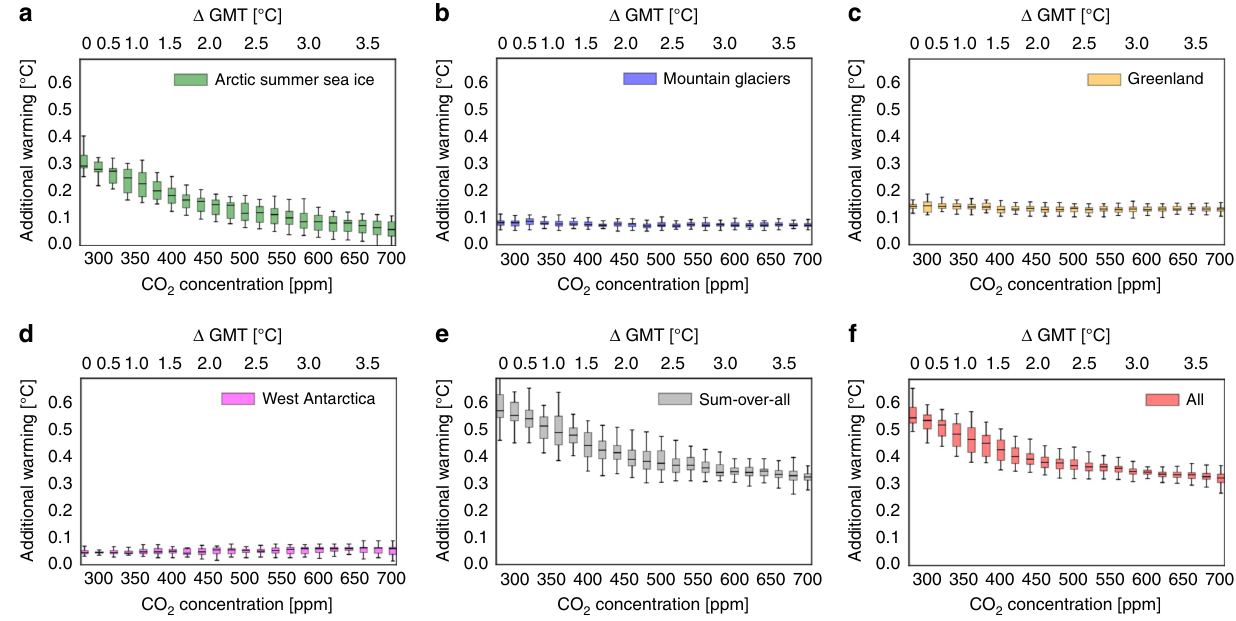
Fig. 3 Linearity of additional warming due to disintegration of cryosphere elements. Additional warming plotted against CO 2 concentration. Disintegration of of cryosphere components separately for ( a ) the Arctic summer sea ice, ( b ) the mountain glaciers, ( c ) the Greenland Ice Sheet, ( d ) the West Antarctic Ice Sheet, ( e ) the sum of all additional warmings from the separately disintegrated cryosphere elements and ( f ) the disintegration of all four elements at the same time. The grey bars match the red bars within their errors which means, according to CLIMBER-2, that the warming effect of singular disintegrated cryosphere elements can linearly be added up to the effect of all four elements disintegrated at the same time. Here we show median, interquartile range and full ensemble spread for each CO 2 concentration. The upper horizontal axis shows the temperature increase above pre-industrial, where a least-square fi t converting CO 2 concentration to temperature with python ’ s function scipy.optimize.curve_ fi t was used. The respective fi tted temperatures arise from full ensemble simulations at prescribed CO 2 concentrations, but without removed cryosphere